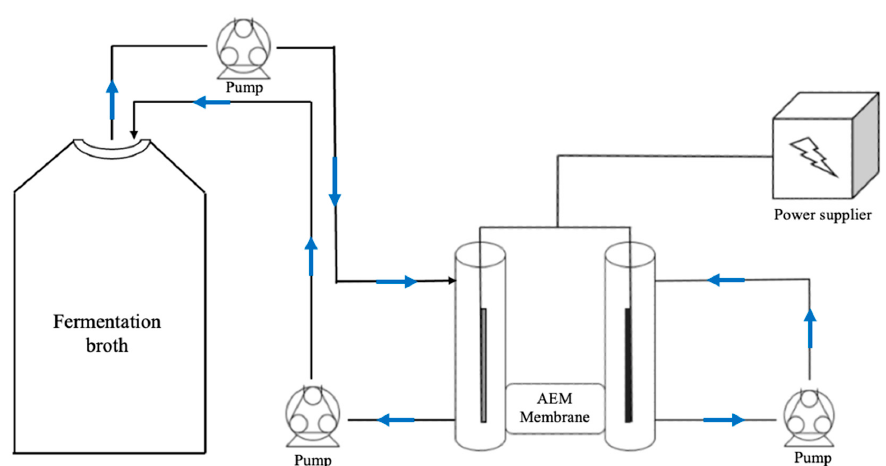
Figure 4. Illustration of the experimental setup of the electrolytic cell in batch mode. The organic acid or broth solution was recirculated between each chamber by peristatic pumps while the electrodes were attached to a power supply to create an electrical driving force from the cathode to the anode chamber. An anionic exchange membrane was inserted between the electrode chambers to ensure a perm-selective extraction of succinic acid and other anions in the solution.